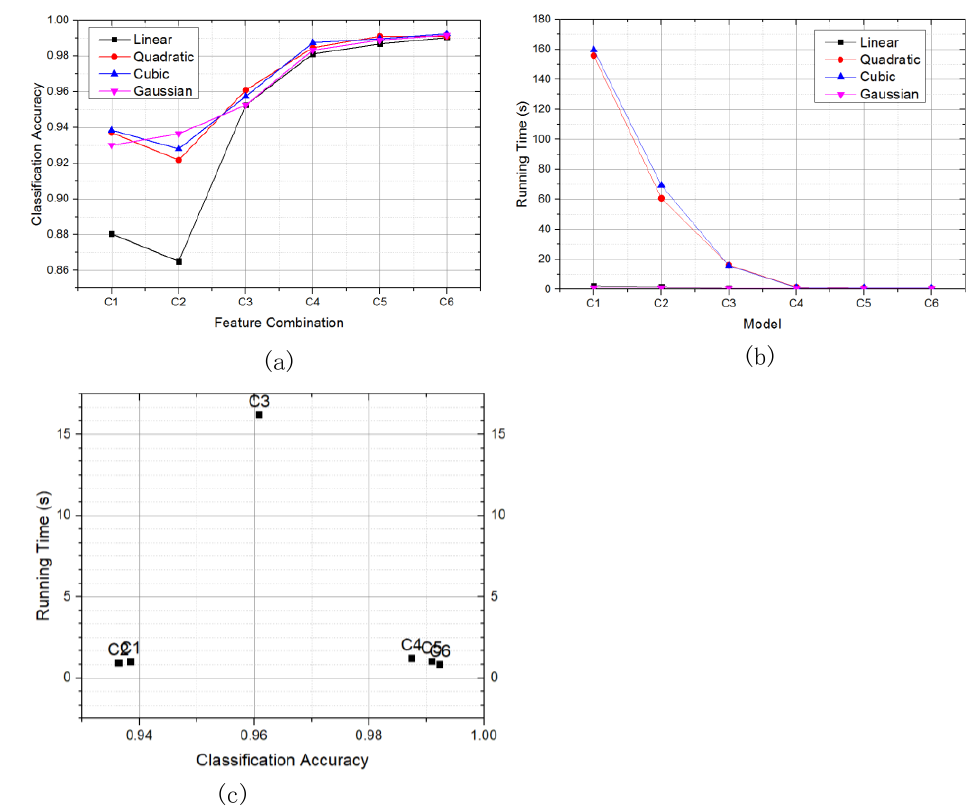
Figure 2. (a) The classification accuracy and (b) running time of SVM over six feature combinations and four types of kernel function, i.e. linear, quadratic, cubic and Gaussian; (c) the relationship between running time and classification accuracy of the best performance of six feature combinations